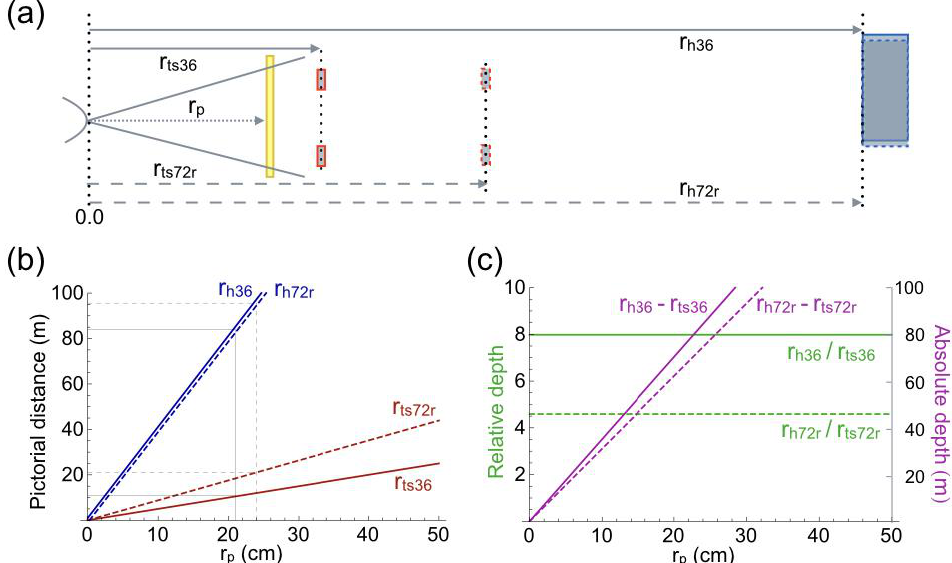
Figure 4. Geometry of the pictorial scenes of Figure 1d. ( a ) Top view of the pictorial scene. Sizes and distances of objects are not to scale. Distances were computed for the traffic sign (r ts36 and r ts72r ) and house (r h36 and r h72r ) depicted in the two pictures. The viewer (curve at the left side) is looking at the pictures (yellow bar) from a distance r p . ( b ) Pictorial distances of traffic signs and houses that produce the same retinal images as their projections in the pictures. Distances are computed as function of r p . Thin lines mark the viewing distances at which the computed distances are equal to the physical distances (see Figure 2a). ( c ) Relative (green) and absolute (magenta) depth between the computed distances of traffic signs and houses as function of r p .